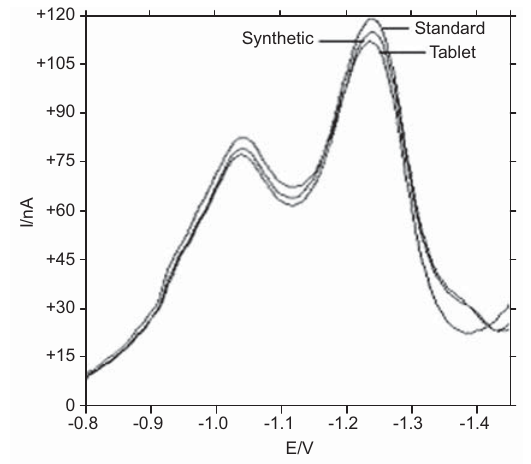
Table 4 Comparison of the results obtained by the SWAdSV,